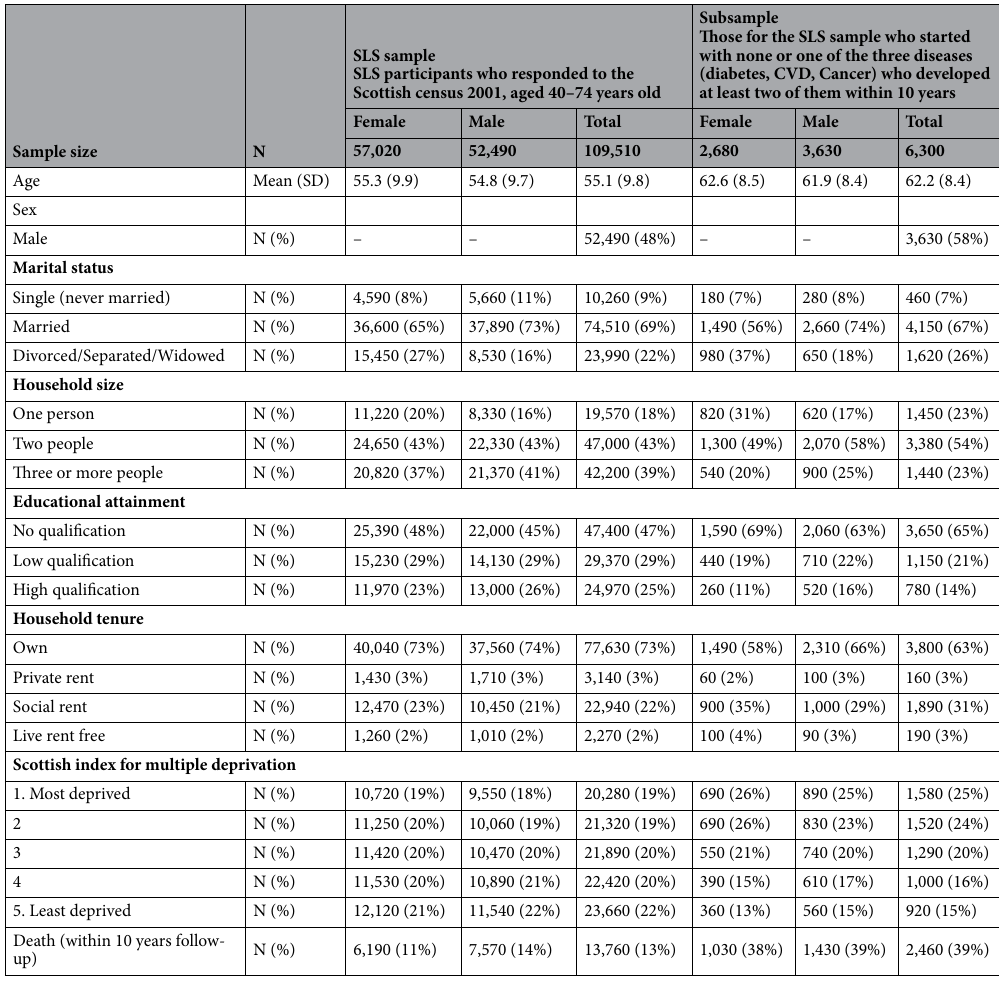
Table 1. Socio-demographic profile of the SLS cohort and the sub-cohort. Source: Scottish Longitudinal Study.